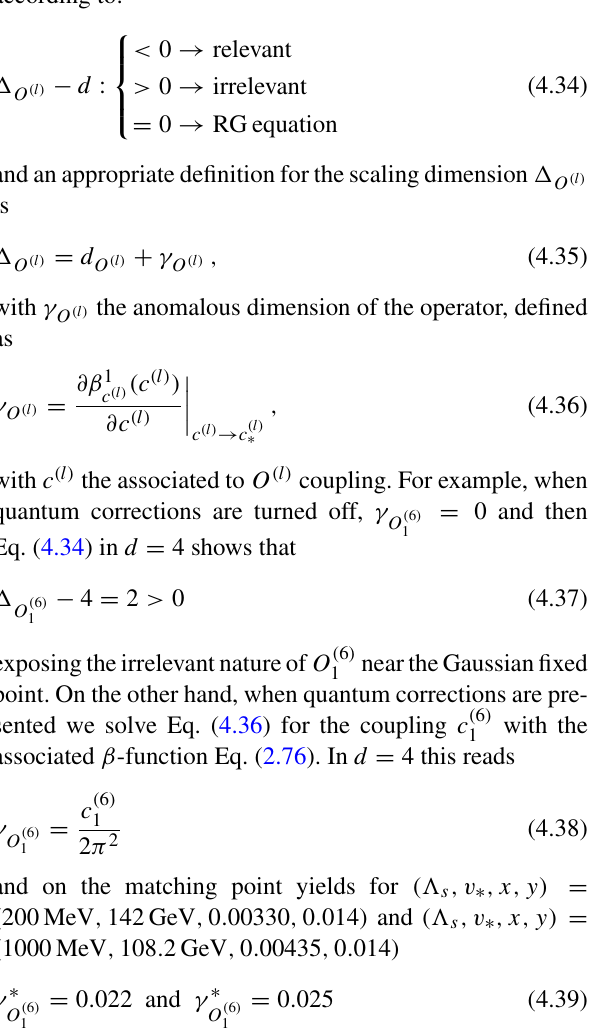
represents the increase of the dynamical scale from the IR (redder dots) to the UV (bluer dots) reaching eventually the cut-off, μ ∗ . The latter is the scale where both RG flows end hitting the same point on the line of phase